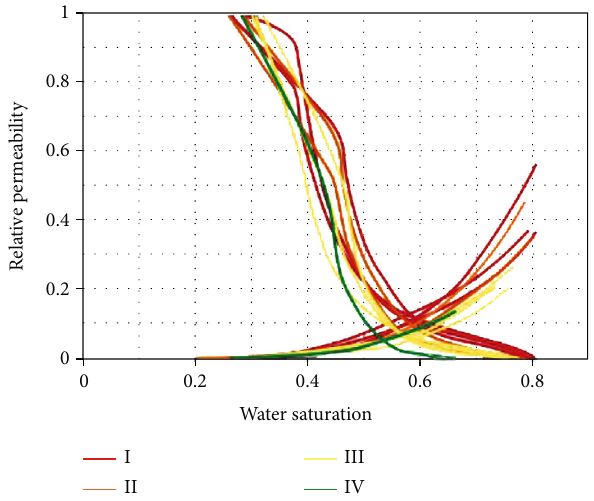
Figure 5: Characteristics of phase permeability curves of di ff erent types of fl ow